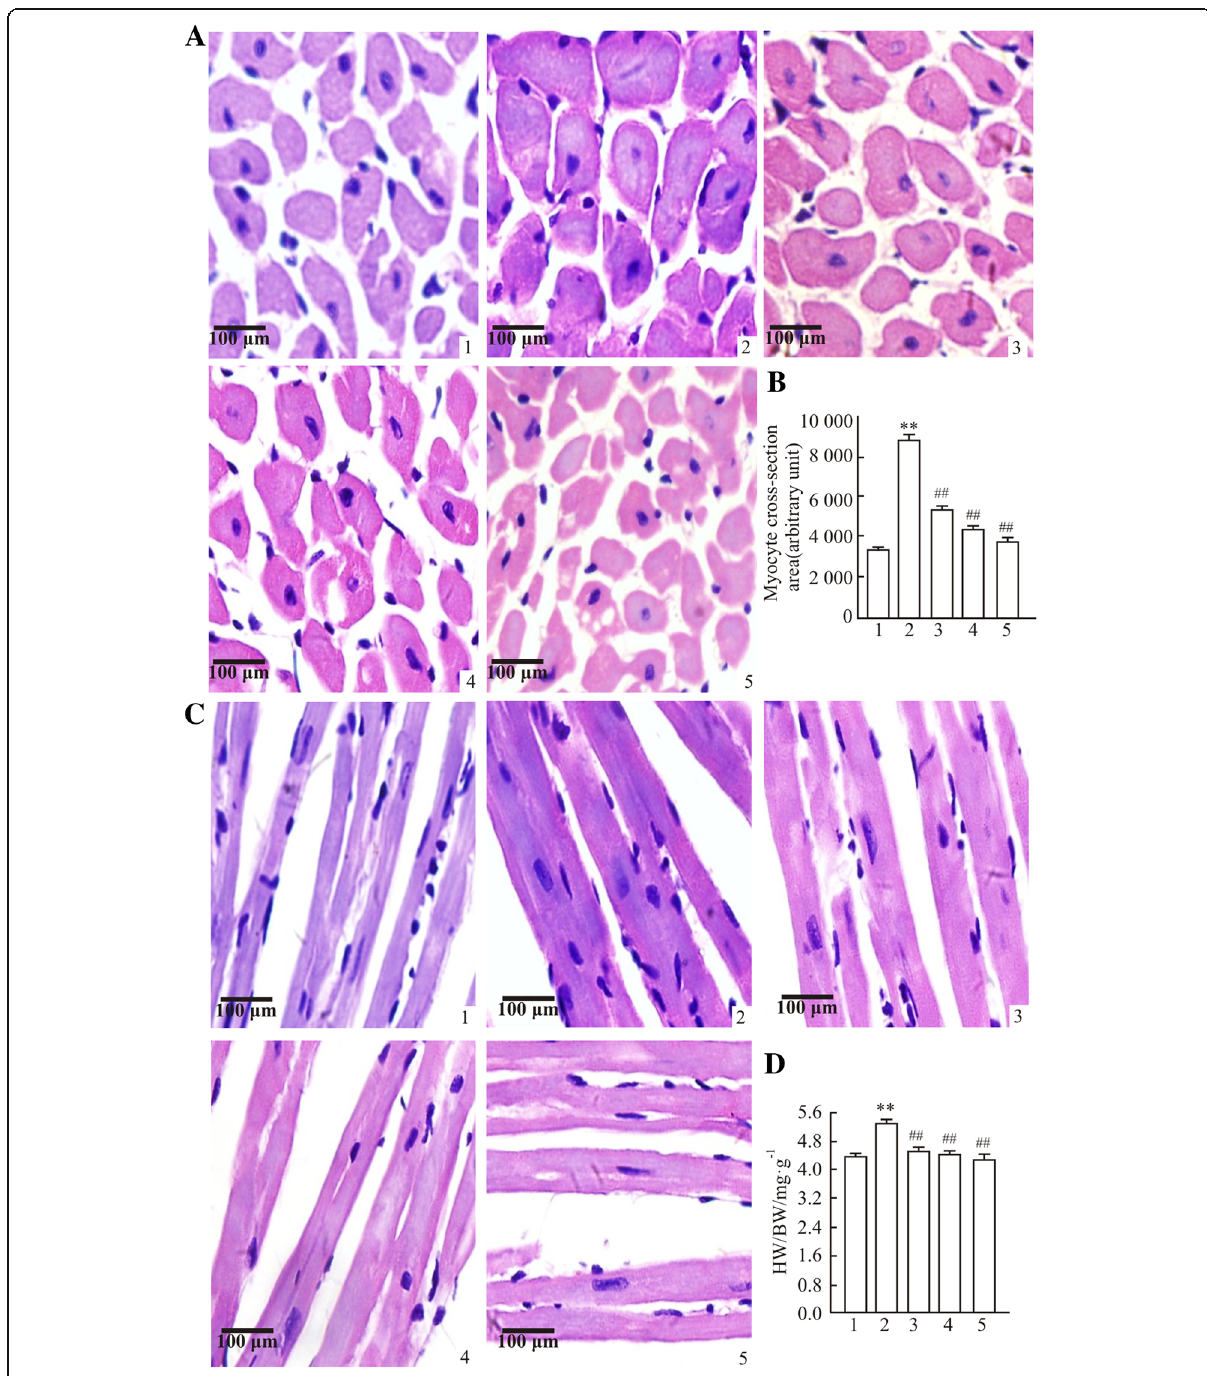
Fig. 4 Effects of polysaccharide extract from XJEK on HW/BW and cardiomyocyte CSA in L -NAME-induced hypertensive mice. ( a ) Representative image of a cardiomyocyte cross-section following HE staining (magnification, × 400). ( b ) Statistic alanalysis of cardiomyocyte CSA. ( c